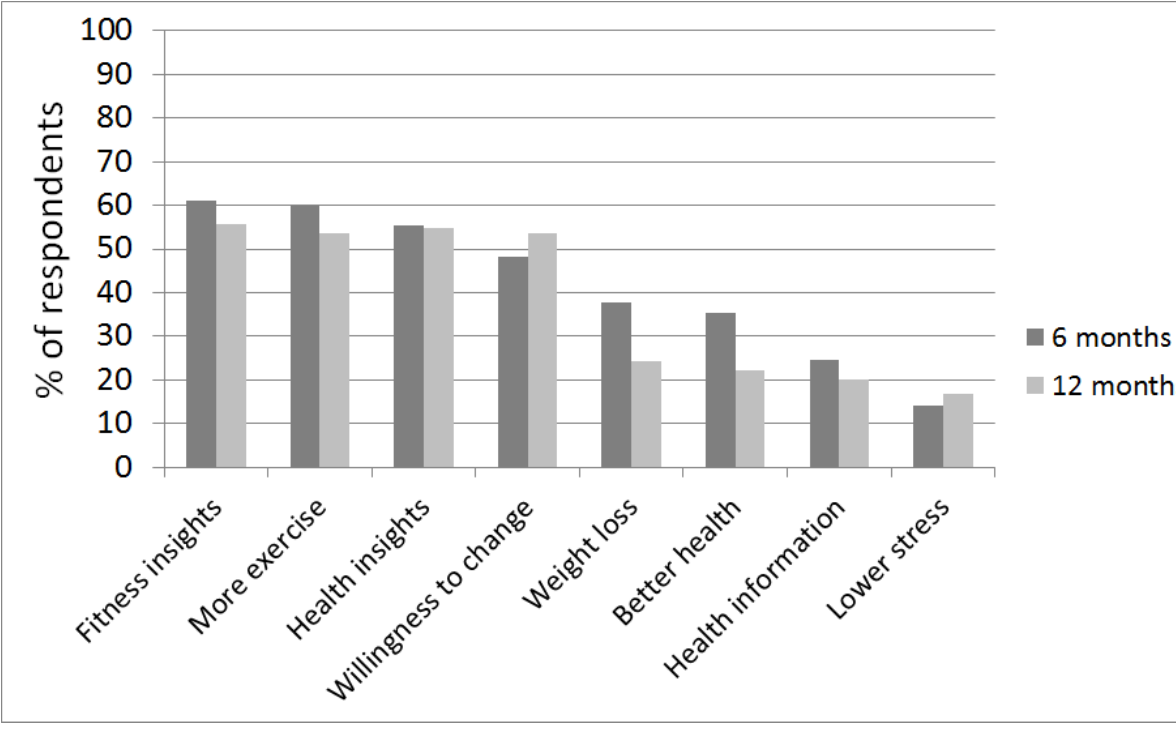
Figure 5. Health-related benefits reported by the